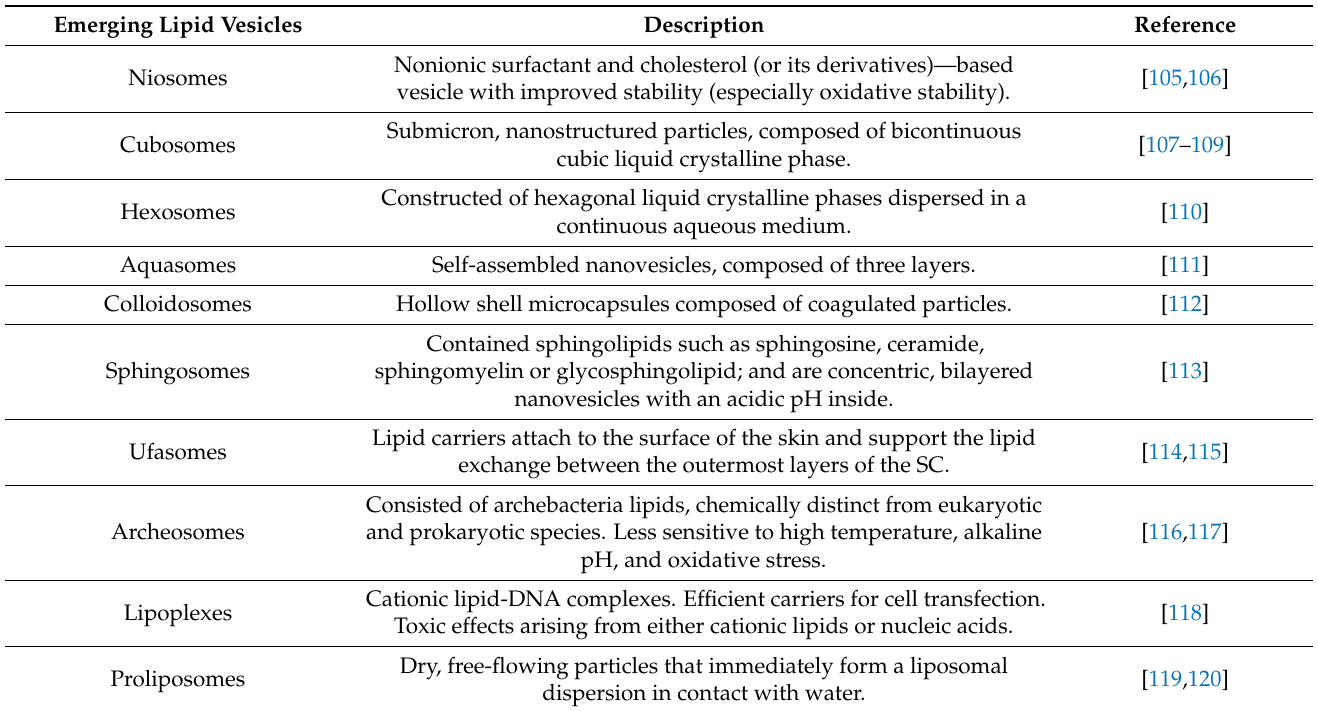
Table 4. Emerging lipid nanovesicular carriers for skin drug